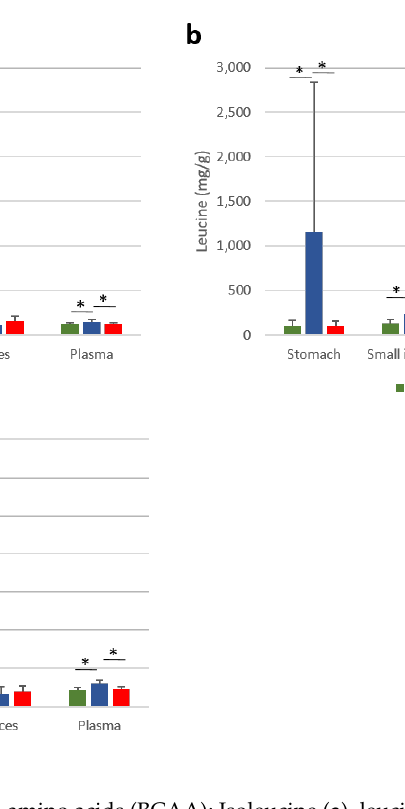
Figure 5. Concentration of branched chained amino acids (BCAA); Isoleucine ( a ), leucine ( b ) and valine ( c ) measured by 1 H nuclear magnetic resonance spectroscopy. The concentrations found to significantly different by ANOVA ( p -value > 0.05) are marked with a star (*). Values reported for gastrointestinal tract are in mg/g while plasma concentrations are expressed in relative values. Chow diet (Chow, n = 6, red), insect-substituted pork sausage diet (Insect, n = 12, blue) or pork sausage diet (Pork, n = 12,